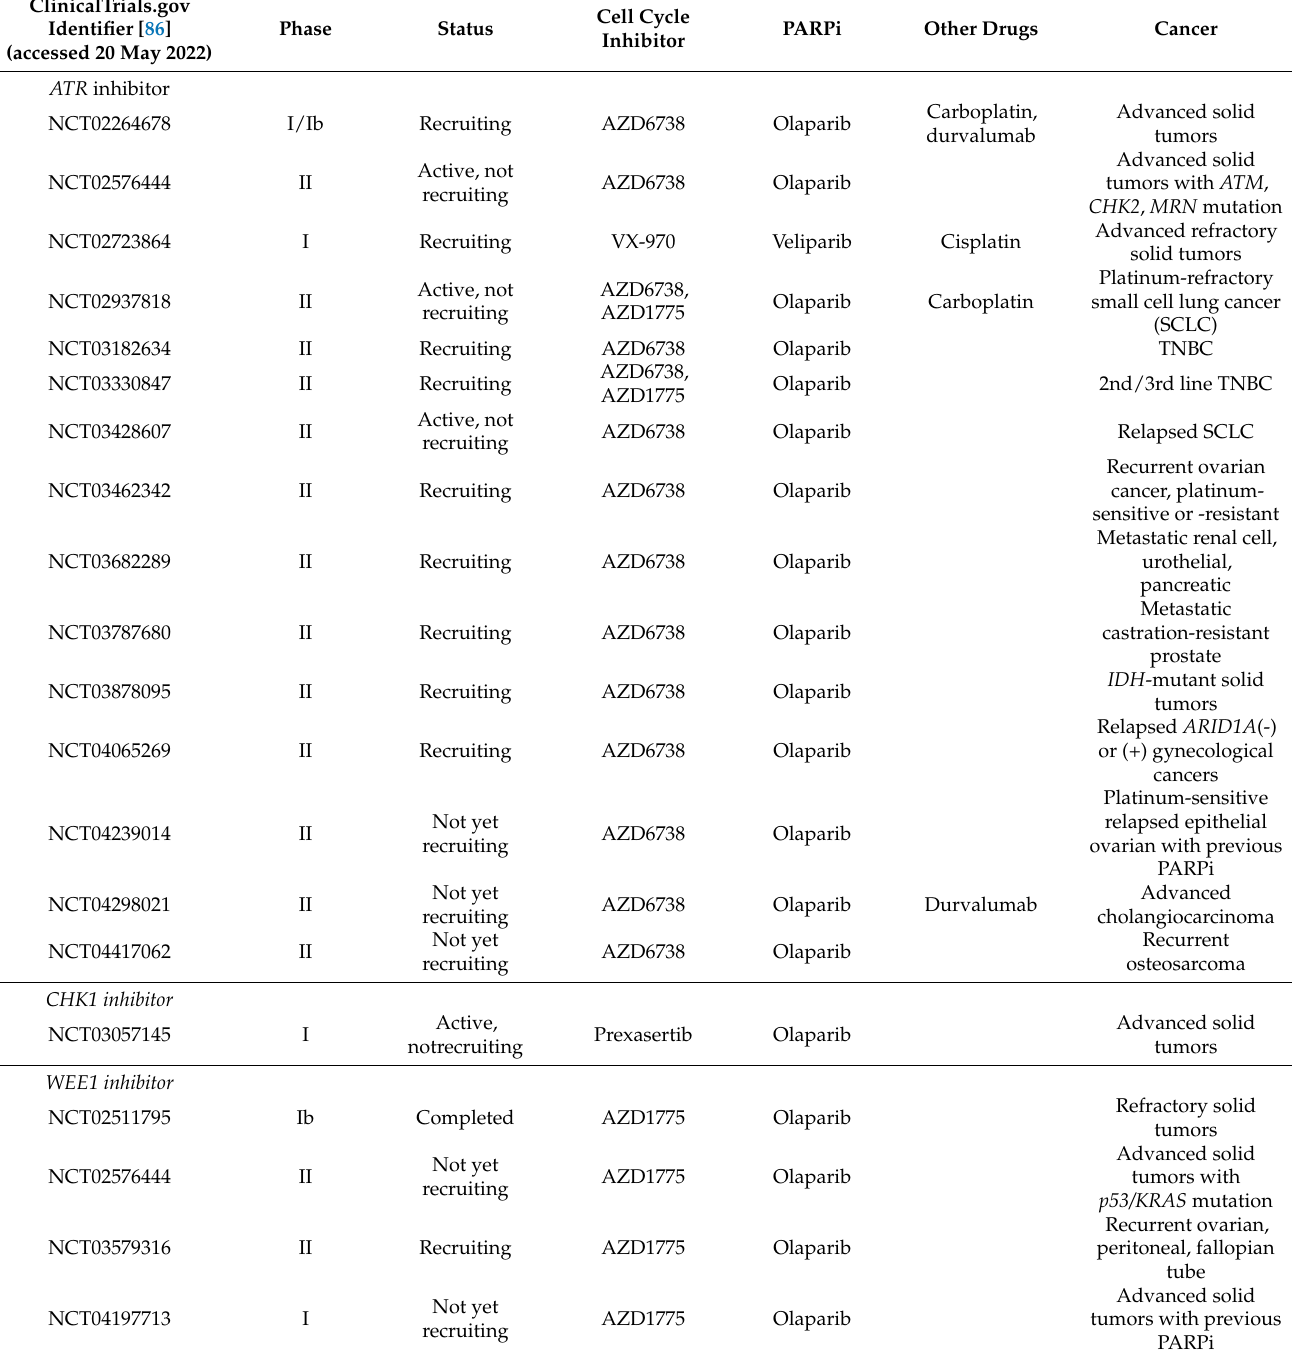
Table 2. Clinical trials evaluating cell cycle inhibitors in combination with